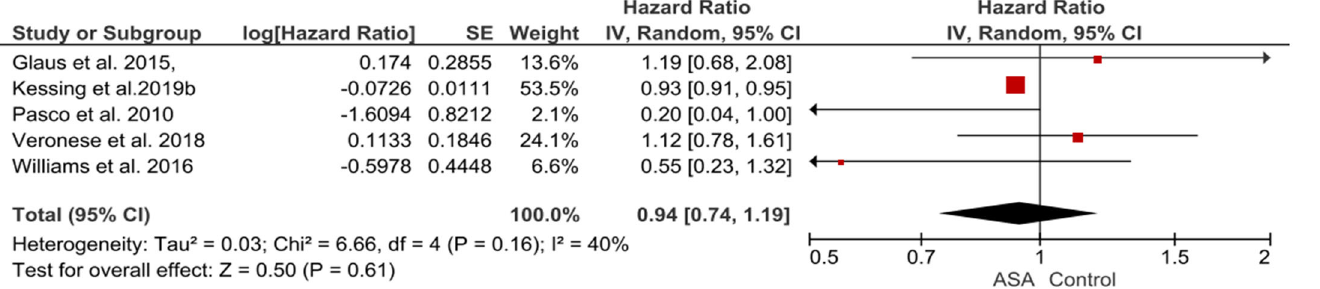
Figure 6. Observational studies on the effect of ASA on the incidence of depression – the pooled Hazard